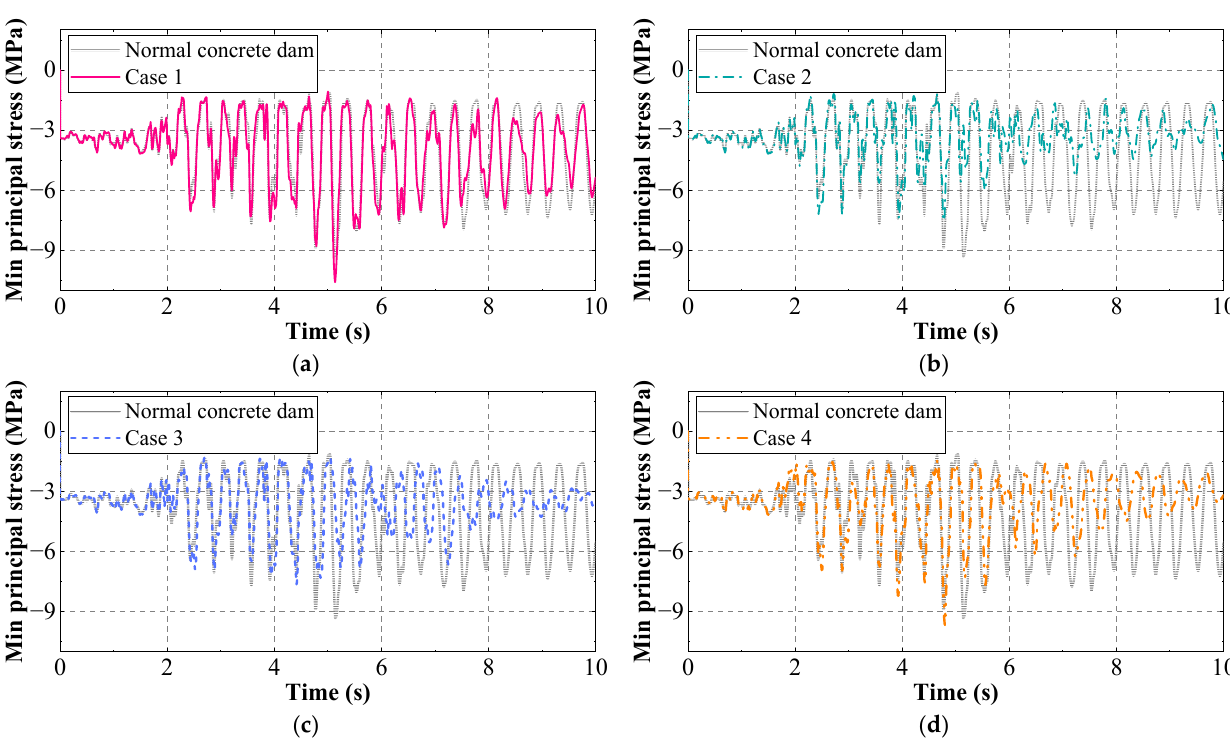
Figure 14. Minimum principal stress responses of the dam heel. ( a ) Case 1; ( b ) Case 2; ( c ) Case 3; ( d ) Case 4.